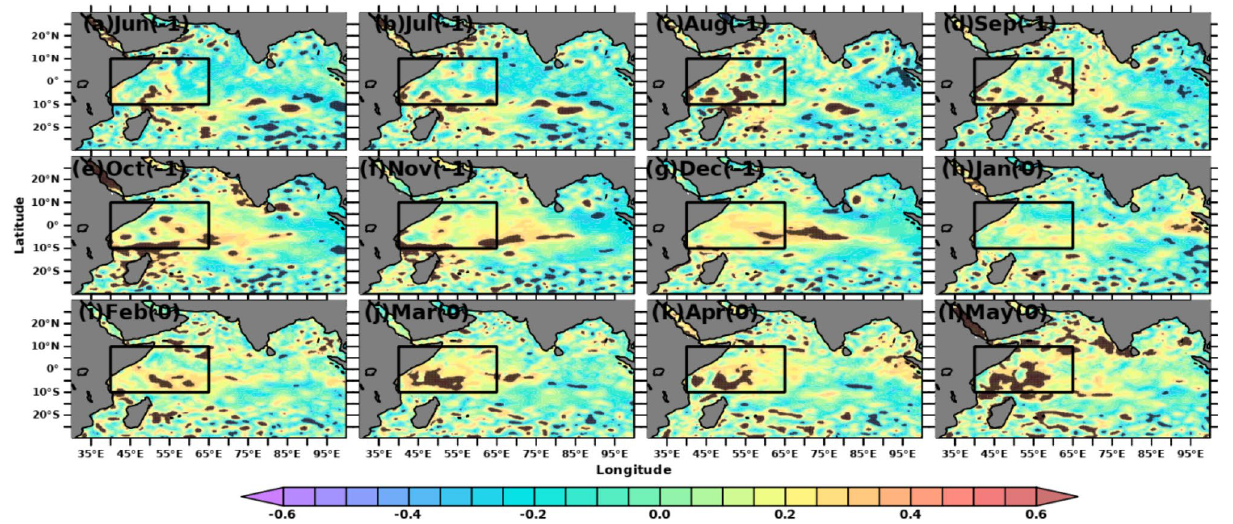
Figure 10. Lagged correlation of detrended AISMR SAI with detrended MSLA over the Indian Ocean. Areas overlapped with black dots are correlations with 90% significance. The figure is generated using PyFerret